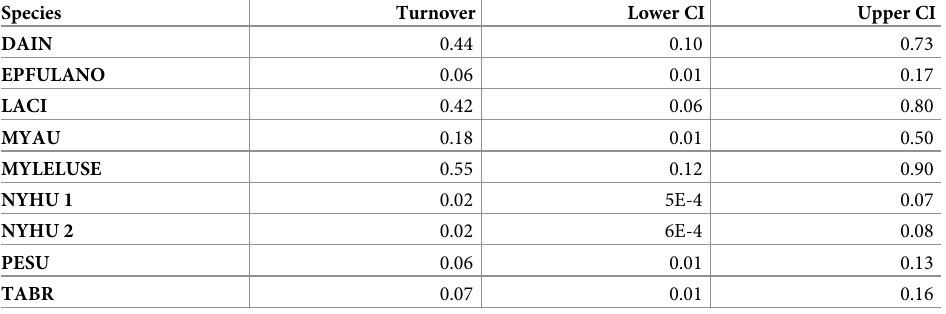
Table 4. Estimated turnover rates of species occupancy across South Carolina from May-July 2015 to May-July 2016. Species Turnover Lower CI Upper CI DAIN 0.44 0.10 0.73 EPFULANO 0.06 0.01 0.17 LACI 0.42 0.06 0.80 MYAU 0.18 0.01 0.50 MYLELUSE 0.55 0.12 0.90 NYHU 1 0.02 5E-4 0.07 NYHU 2 0.02 6E-4 0.08 PESU 0.06 0.01 0.13 TABR 0.07 0.01 0.16 Estimates are based on the top ranked model for each species. Lower and Upper CI indicate 95% credible intervals. Refer to Table 1 for species code